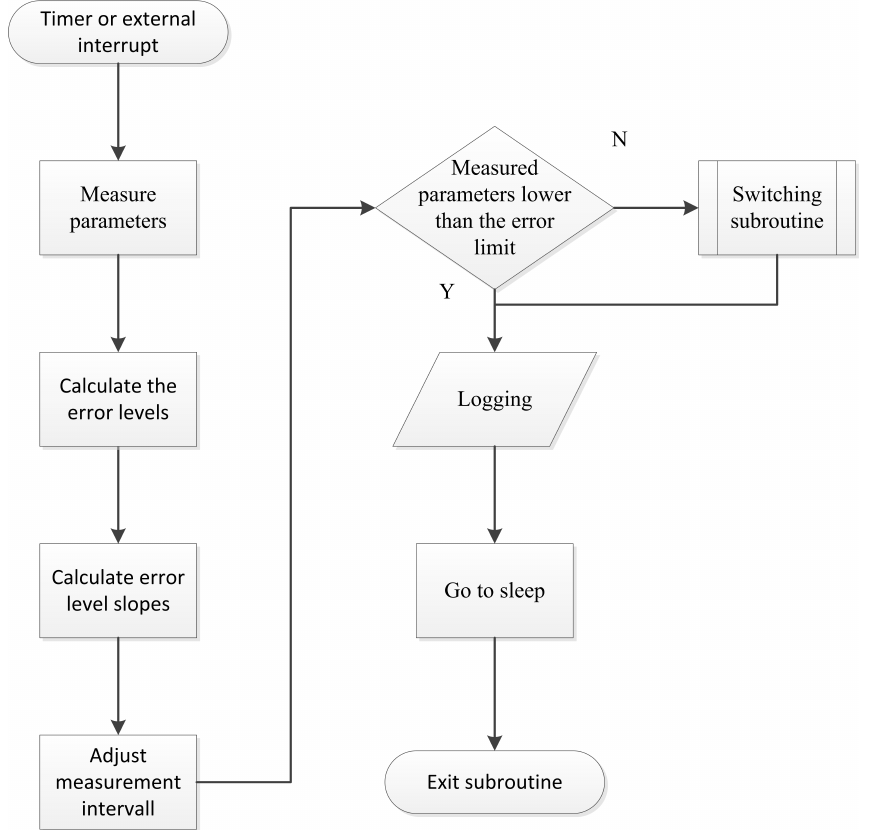
Figure 12. Parameter measuring